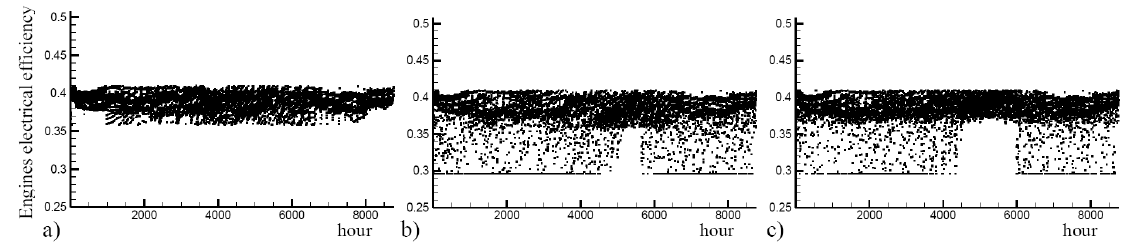
Figure 10. Hourly based electrical efficiency of the engines for a reference year in ( a ) BC, ( b ) ReC, and ( c ) DeReC.